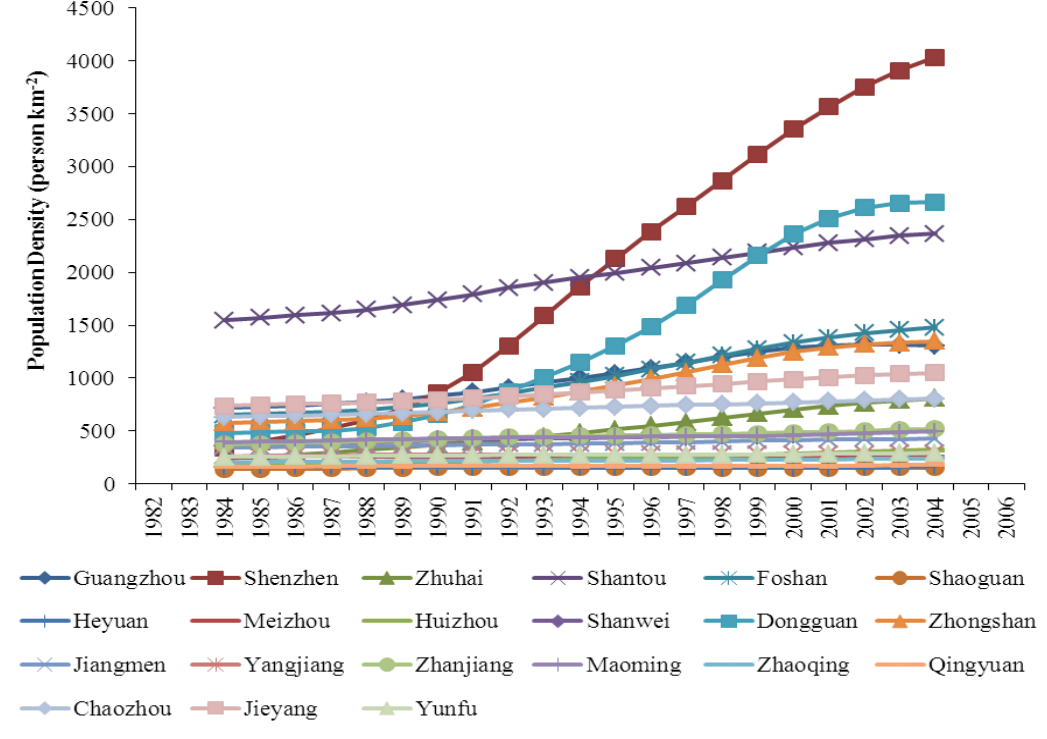
Figure 2. Trends in population density of 21 cities during the period from 1982 to 2006. Note: A 5-year smoothing interval is used to clearly show the trends.